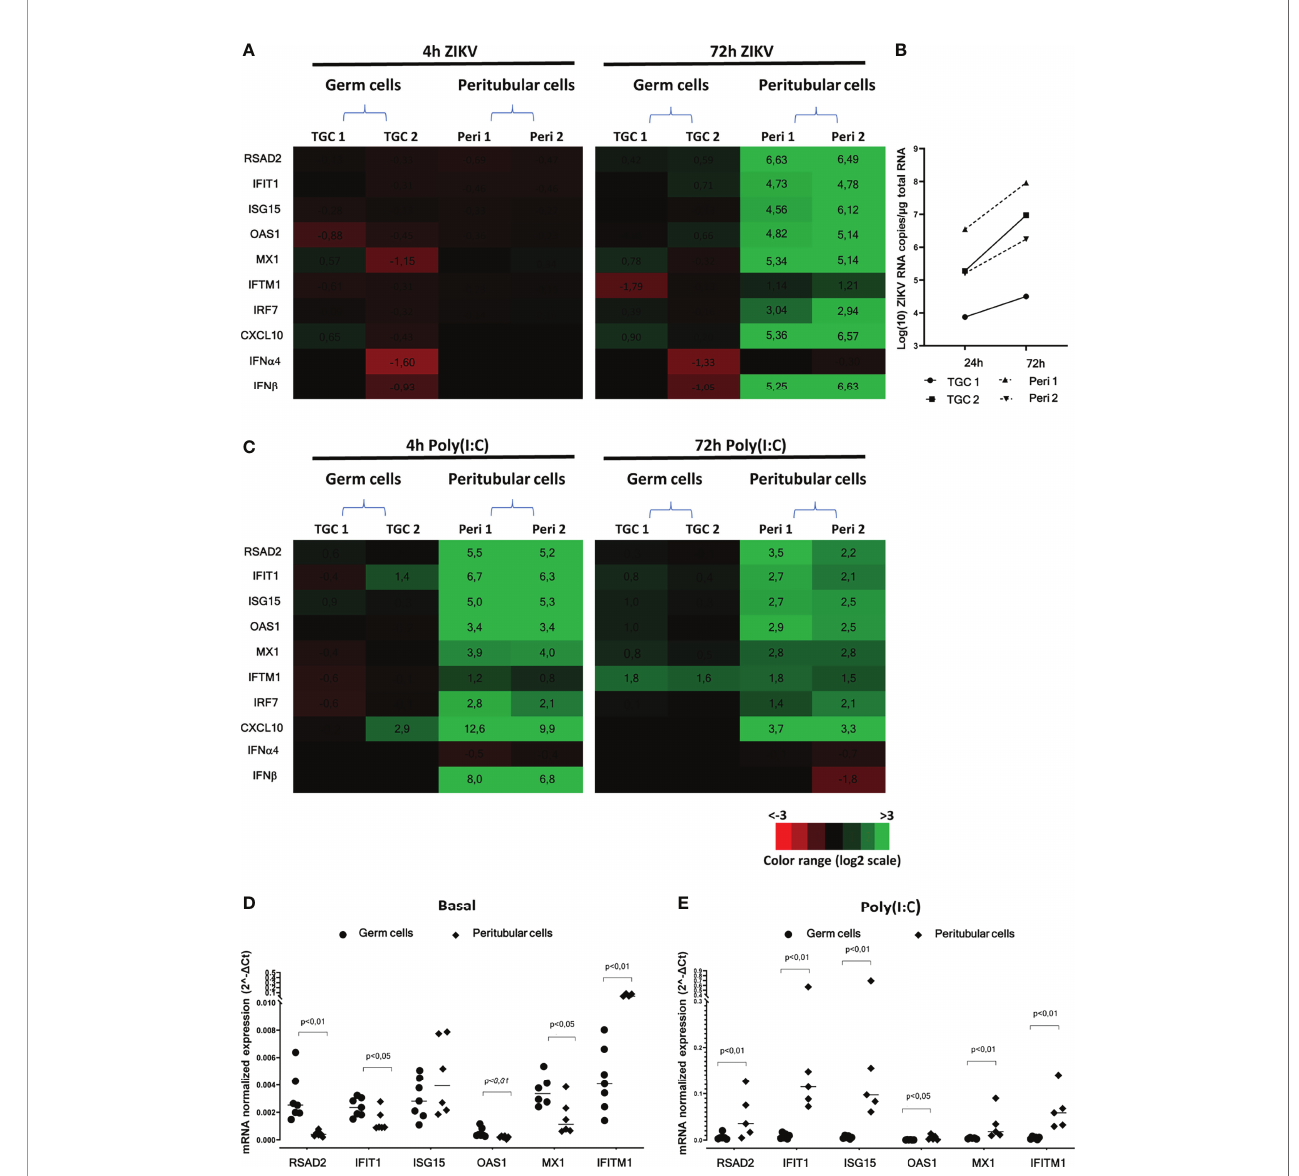
FIGURE 2 | Human isolated testicular cells immune response following ZIKV infection or Poly(I:C) stimulation. Primary human testicular peritubular or germ cells isolated from seminiferous tubules were infected 2h with ZIKV MOI=1, trypsined and cultured for 4 and 72h (A, B) , or stimulated with Poly(I:C) 10µg/mL for 4 and 72h (C, E) . Innate immune gene expression was determined by RTqPCR. Heatmap show log2 – transformed expression ratios between ZIKV-infection or Poly(I:C) stimulated and time-matched mock-infected controls (A, C) . Green indicates upregulation and red downregulation of mRNA compared with controls. Two representative donors are shown. ZIKV RNA levels were measured by RT-qPCR in the primary germ cells and peritubular cells at 24h and 72h post-infection (B). Basal (D) and 4h Poly(I:C)-stimulated (E) level of mRNAs expression of a panel of antiviral effectors in germ cells (circles) and peritubular cells (diamonds). Each symbol corresponds to a donor. Horizontal bars represent the median. Mann-Whitney non-parametric